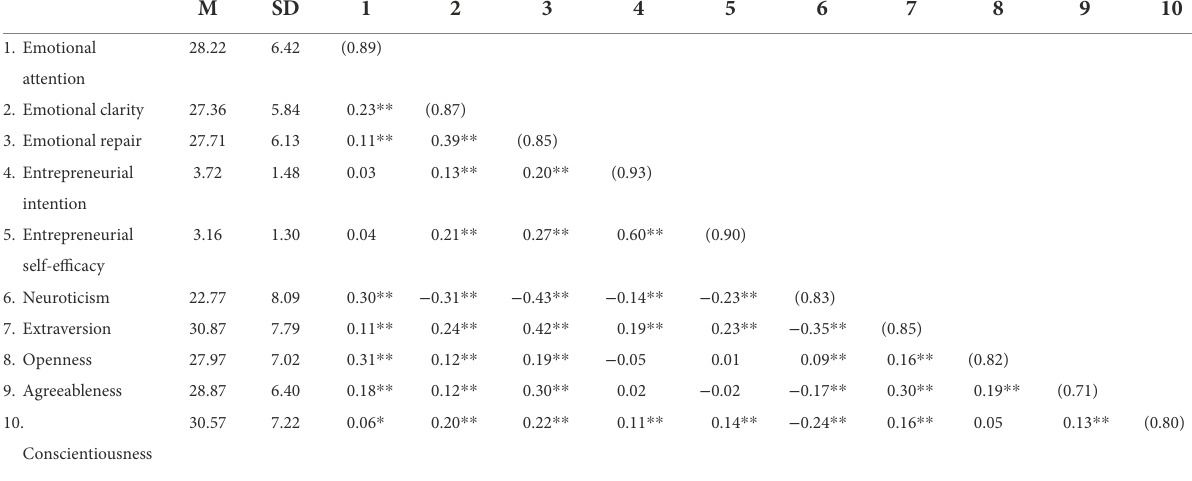
TABLE 1 Means, standard deviations (SD), correlations, and reliabilities (on the diagonal in brackets).